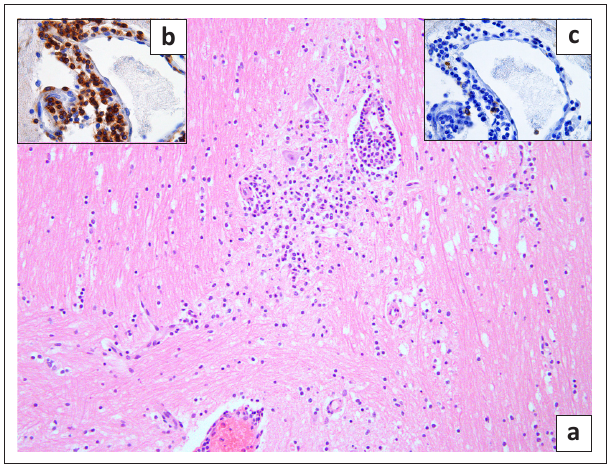
FIGURE 9: (a) Thalamus of lineage 1 West Nile virus Case 7 showing perivascular lymphoplasmacytic cuffing and multifocal glial nodules. (b) Case 7 thalamus with perivascular cluster of differentiation 3+ (brown) T-lymphocytes. Cluster of differentiation 3 immunoperoxidase using LASB+ DAB as chromogen and haematoxylin counterstain x 1000. (c) Case 7 thalamus with perivascular cluster of differentiation 20+ (brown) B-lymphocytes or plasma cells. Cluster of differentiation 20 immunoperoxidase using LSAB+ DAB as chromogen and haematoxylin counterstain x 1000.